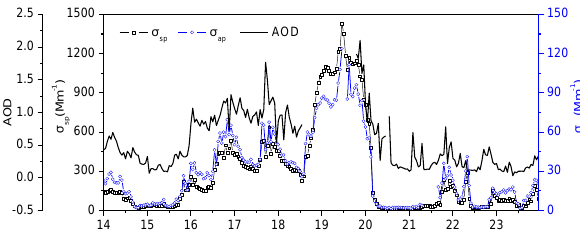
Fig. 5. Time series of aerosol scattering ( σ sp ) , absorption coefficient ( σ ap ) and aerosol optical depth (AOD) at SDZ from 14 to 23 January 2010.